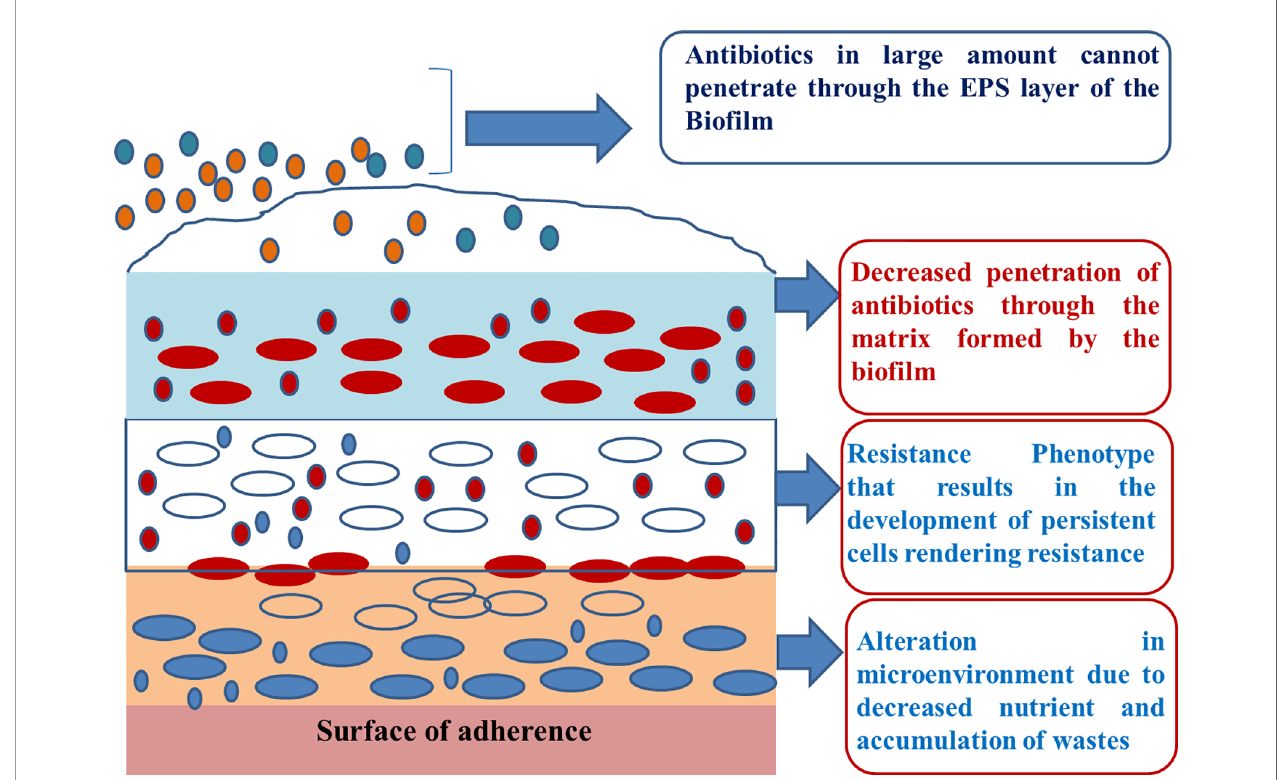
FIGURE 1 | Development of resistance against antimicrobial